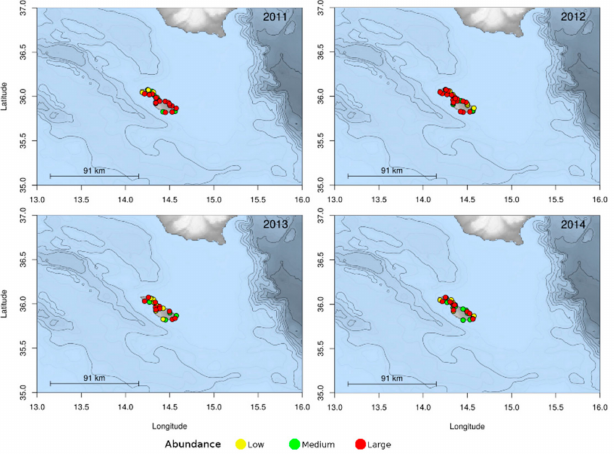
Figure 8. Spatial distribution of jellyfish reports from 2011 (upper-left panel) to 2014 (lower-right panel) for Pelagia noctiluca in Malta. Abundance categories are shown as follows: category 1—“low” in yellow, category 2—“medium” in green, and category 3—“high” in red.